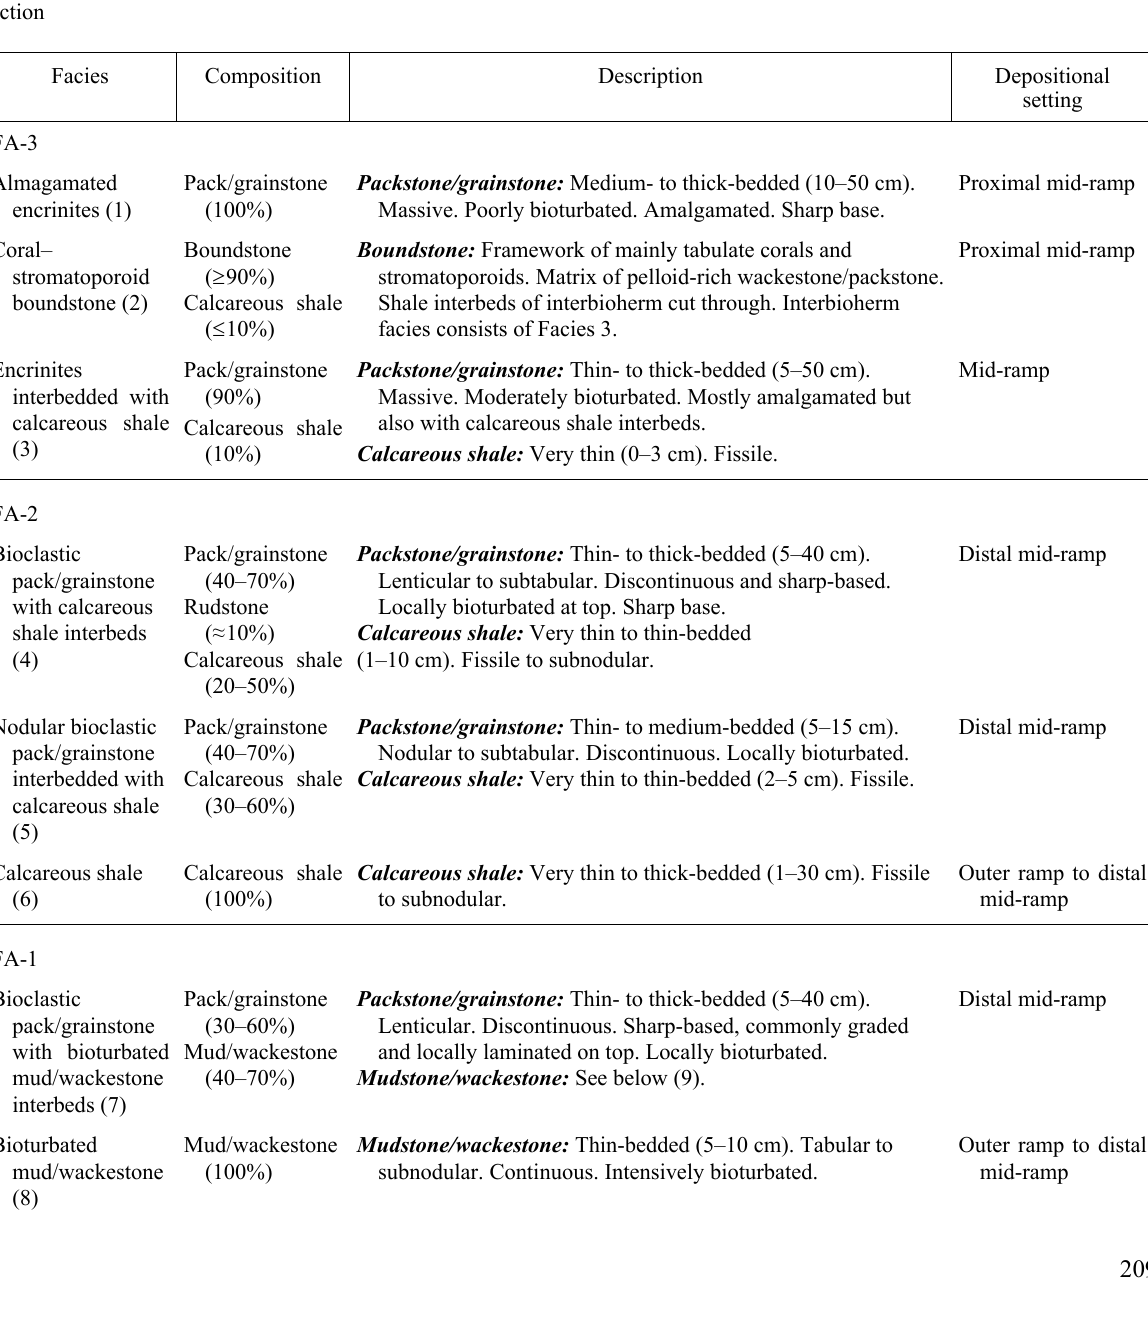
Table 1. Description and interpretation of the facies identified across the Jupiter(cid:150)Chicotte formational boundary in the Jumpers